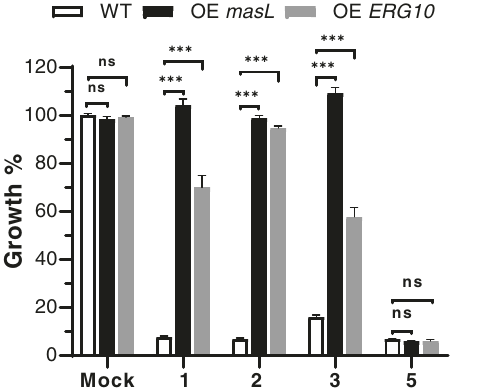
Fig. 4 C. albicans was rescued by heterologous overexpression of masL (OE masL ) and ERG10 (OE ERG10 ) from the minimum inhibitory concentration of collimonin C/D 1, 2, massilin A 3, and massilin C 5. The cell viabilities were normalized to the mock treatment. The standard deviation was calculated based on three replicates and the two-tailed Student ’ s t -test for statistical analysis. *** P- value < 0.000001. ns: not signi fi cant. Each experiment comprised three biological replicates ( N = 3). All data values were listed in Supplementary Table 7.